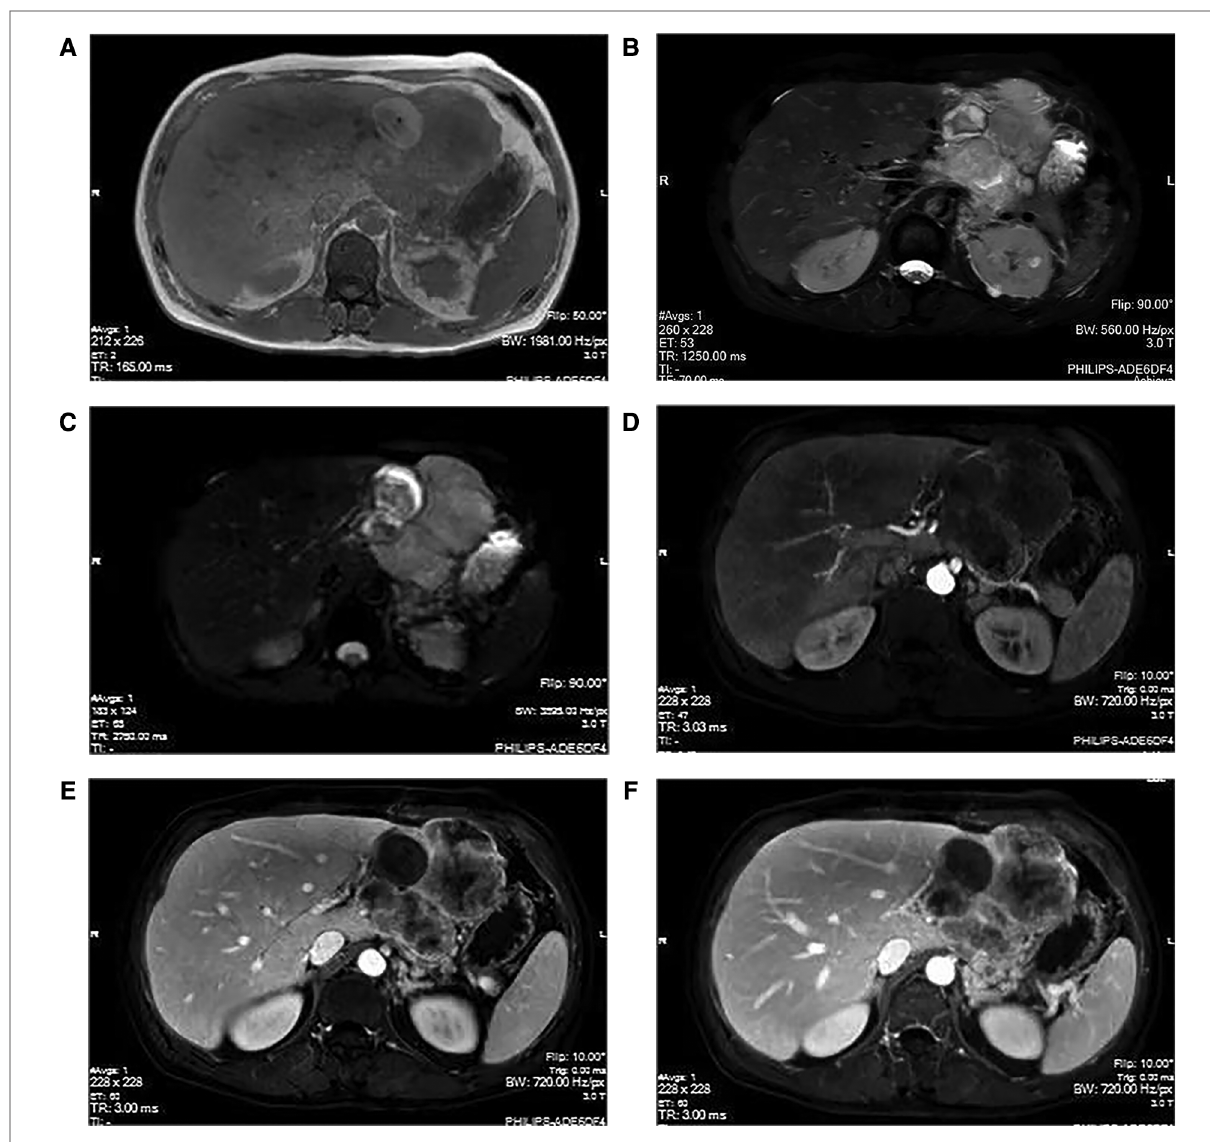
FIGURE 1 MRI manifestations of hepatic sarcomatoid carcinoma. The magnetic resonance imaging (plain scan+enhanced+functional imaging) shows abnormal signals of irregular mass in the liver, with a size of approximately 9.5×8.3 cm. The T1WI ( A ) shows a weak signal; however, the T2WI ( B ) and the DWI ( C ) show strong signals. The arterial phase ( D ) indicates slightly uneven enhancement at the edge of the lesion, with continuous uneven enhancement in the portal phase ( E ) and delayed phase ( F